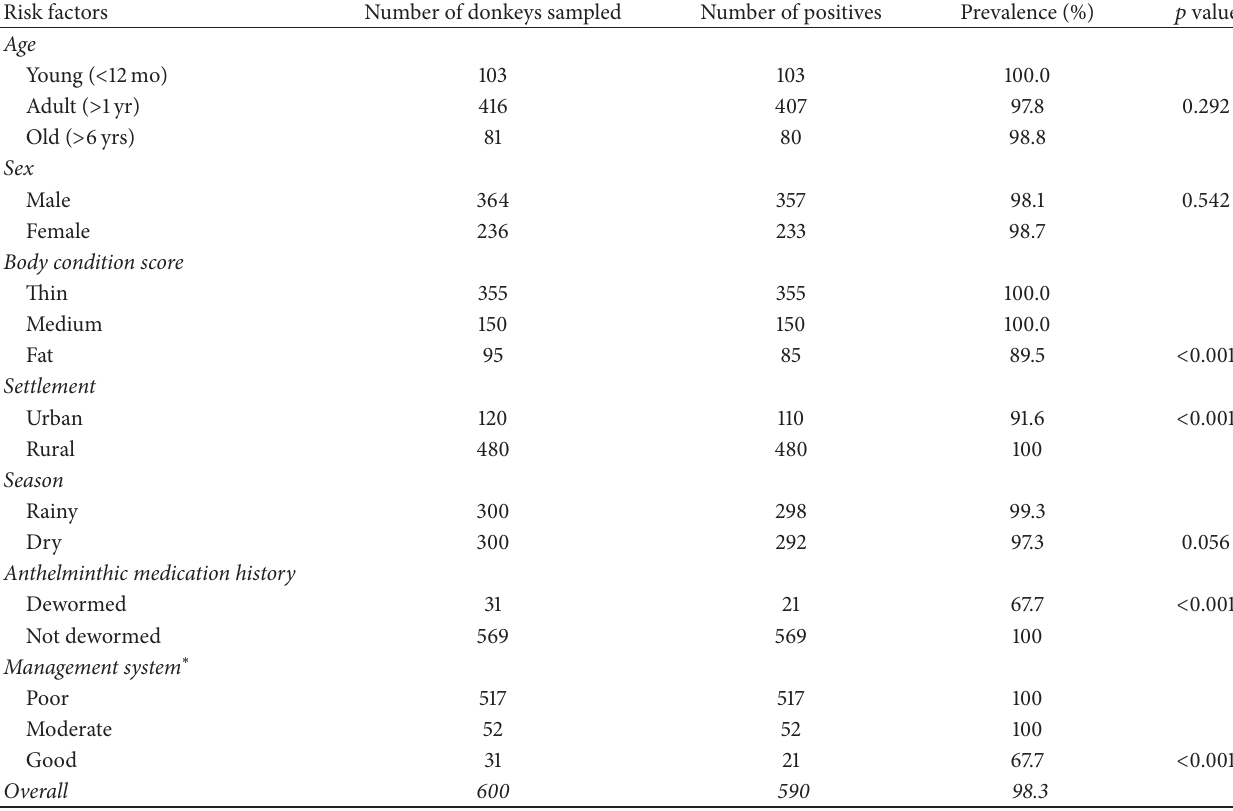
Table 1: Risk factors associated with the occurrence of gastrointestinal helminthosis in northeastern